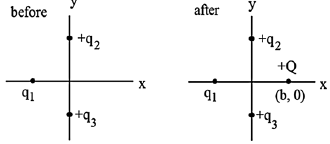
FIG. 2. Figure provided for Q8 on the CSEM.